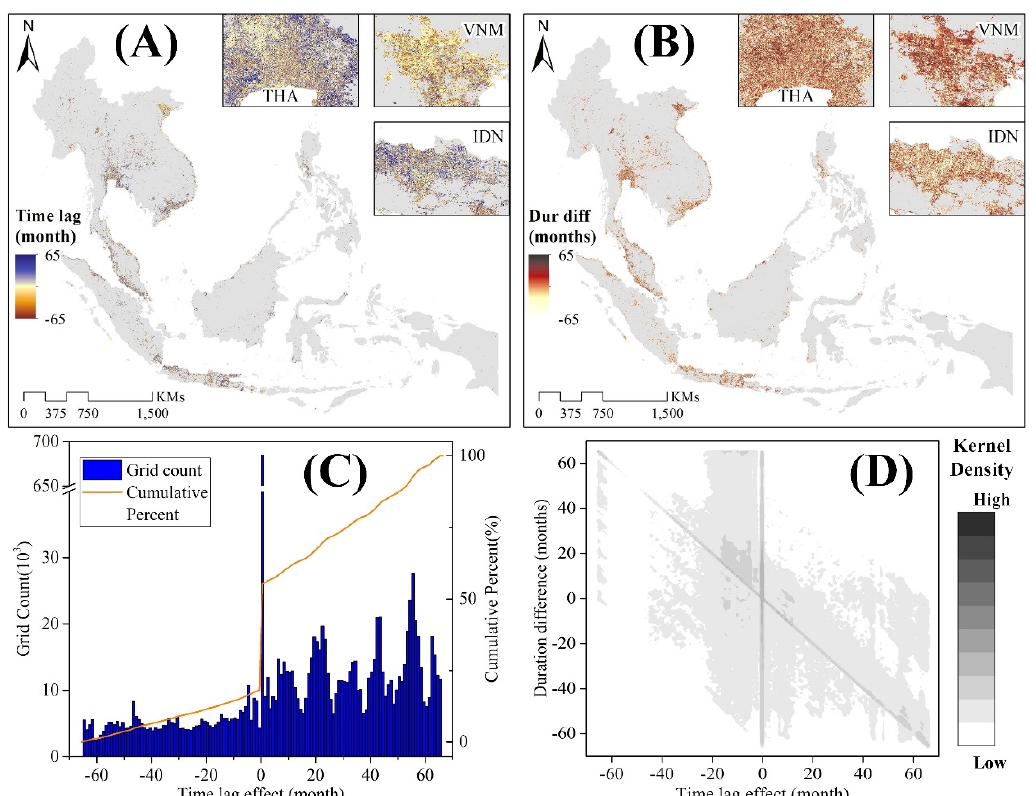
Figure 6 . Spatial distribution of time lag effect (A) and duration difference (B) between Figure 6. Spatial distribution of time lag effect ( A ) and duration difference ( B ) between MODIS/NDVI maximum trend and MODIS/NDVI maximum trend and VIIRS/DNB maximum trend. The histogram and cumulative VIIRS/DNB maximum trend. The histogram and cumulative percent of grid count for time lag effect ( C ) and the bivariate percent of grid count for time lag effect (C) and the bivariate kernel density between time lag effect kernel density between time lag effect and duration difference ( D ) for VIIRS change areas (grids count: ≈ 1.85 × and duration difference (D) for VIIRS change areas (grids count: ≈ 1.85×106).